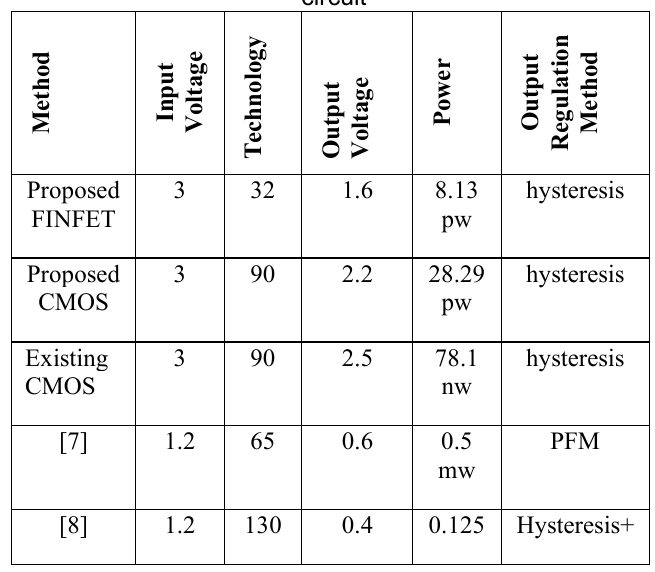
Table 4. Comparison of various parameters between existing and proposed switched capacitor